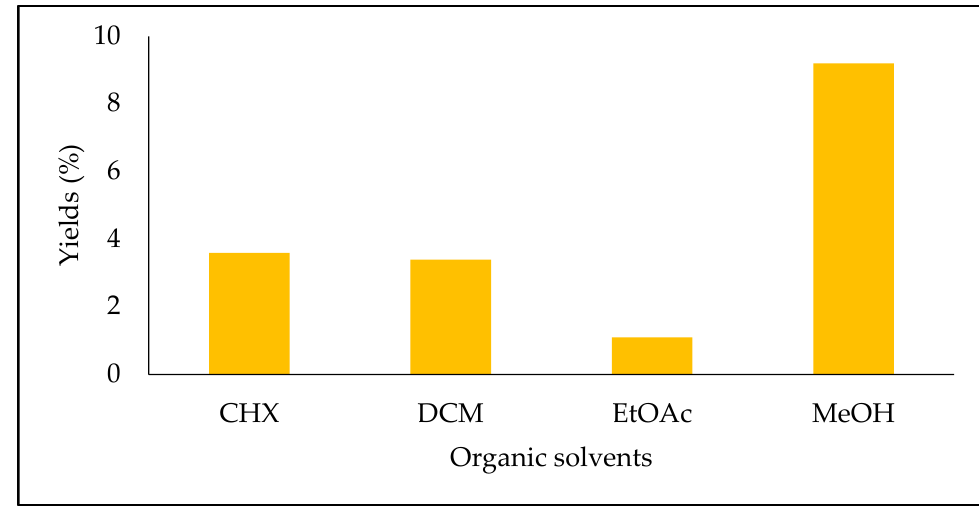
Figure 1. Extraction yields of Salvia fruticosa extracts (%).